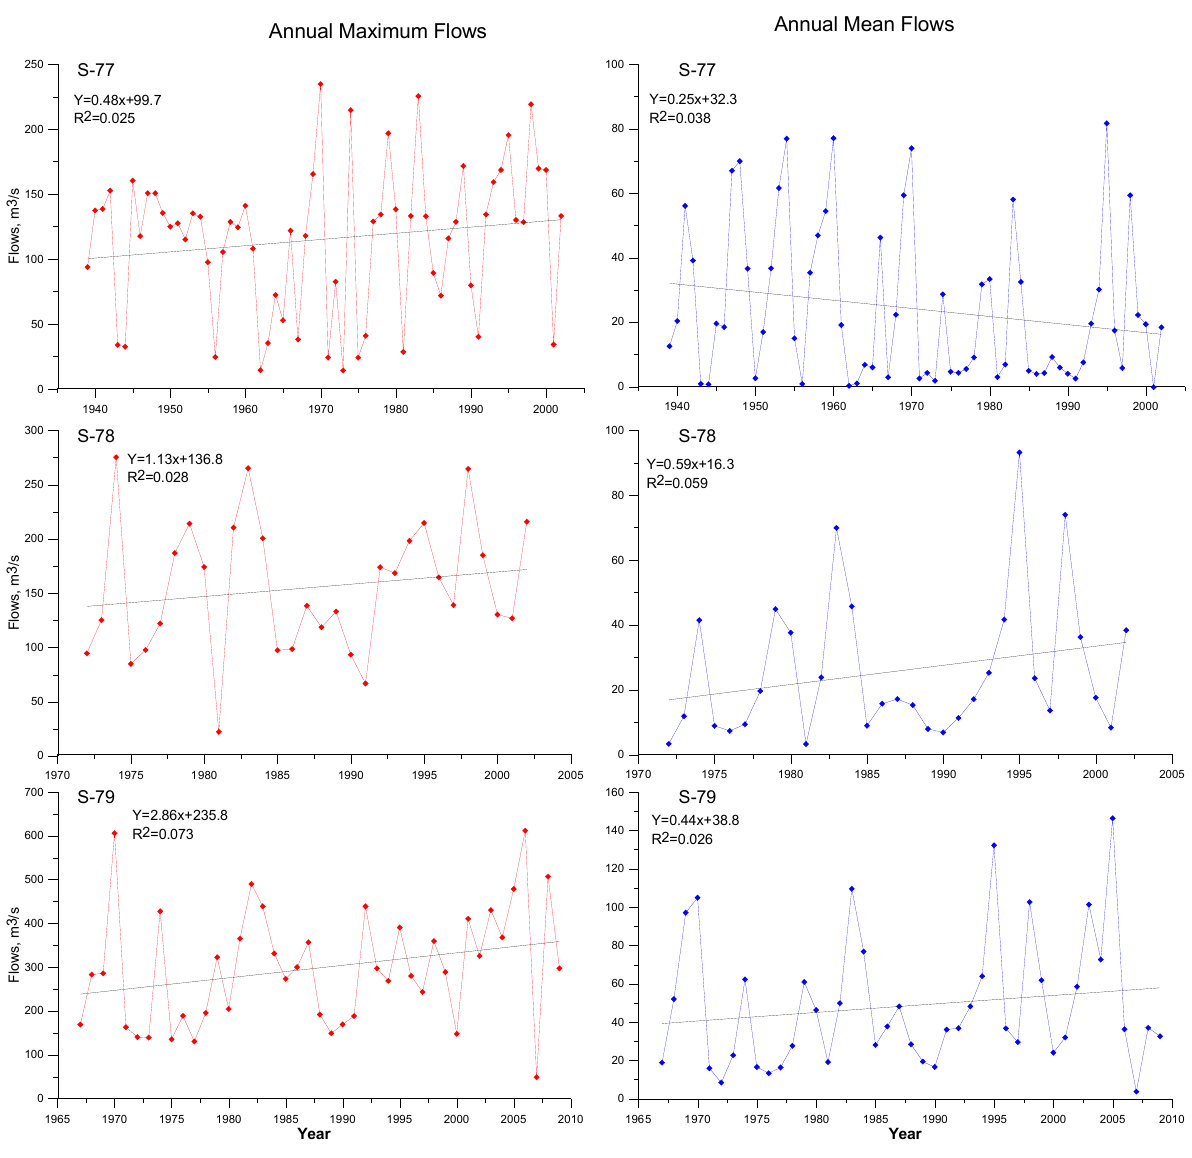
Figure 6. Annual maximum and mean flow time series at the three stations in the Calooshatchee River Watershed.